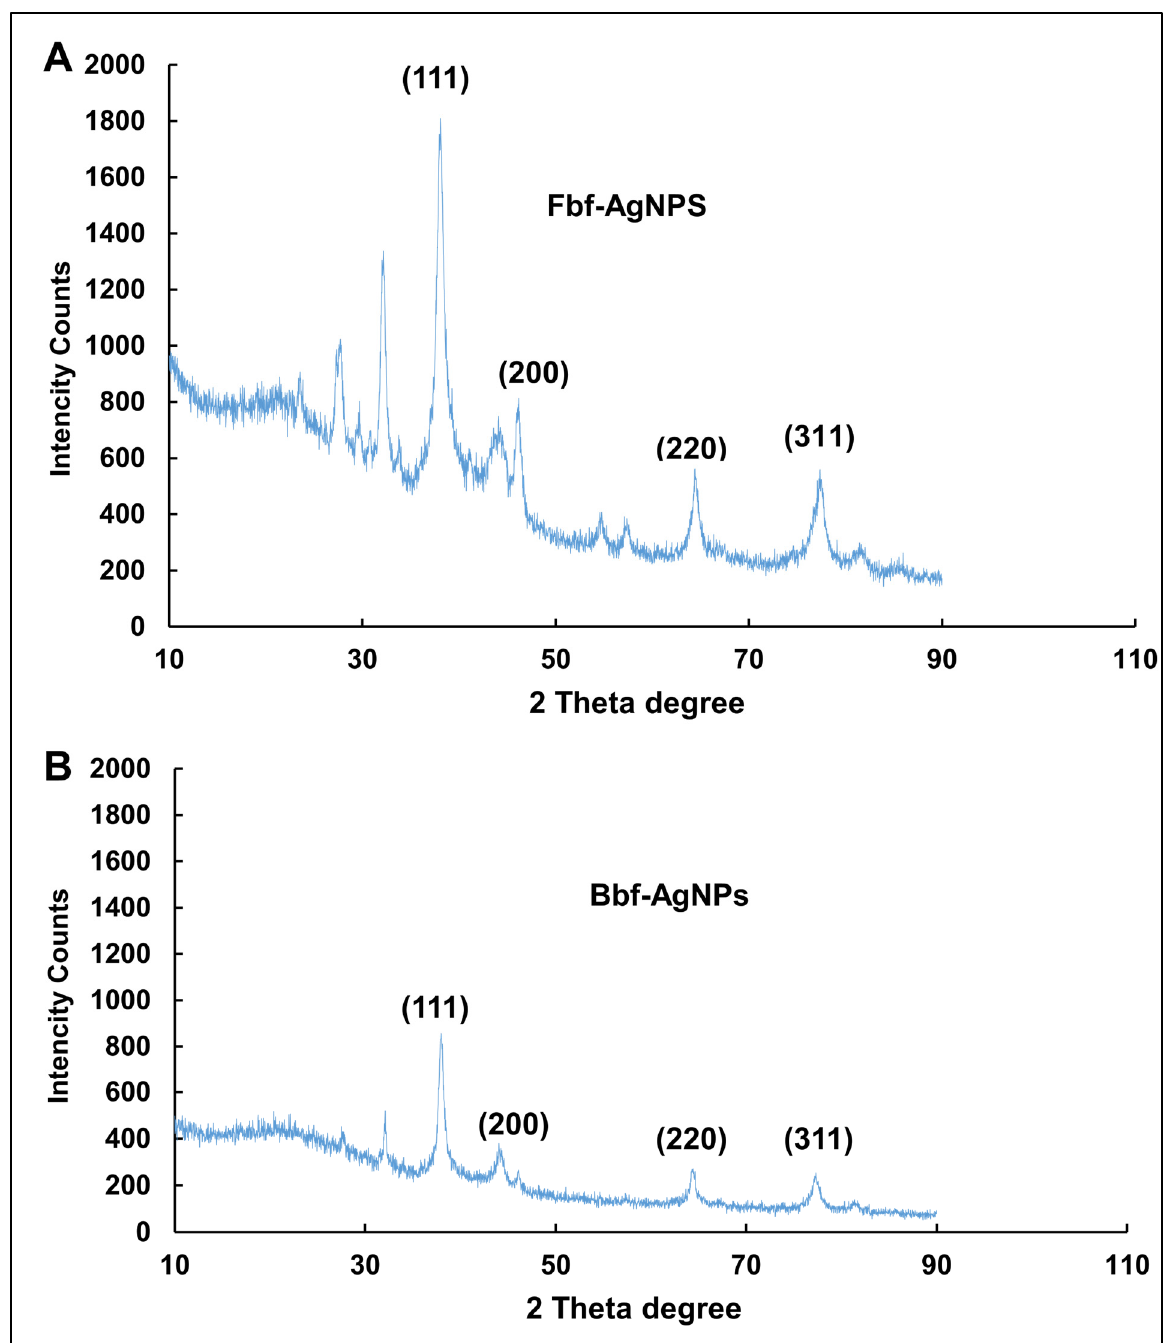
Figure 3. XRD spectra of the biosynthesized nanoparticles. ( A ) Fbf-AgNPs and ( B ) Bbf-AgNPs. The Fbf-AgNPs and Bbf-AgNPs hydrodynamic diameter or distribution of size and surface charges were evaluated through DLS and Zeta potential study. The hydrodynamic diameter or size distribution (average size) of Fbf-AgNPs and Bbf-AgNPs is 91.09 d.nm and 122.9 d.nm, respectively, with the PDI value of 0.233 mV and 0.301 mV (Figure 5).